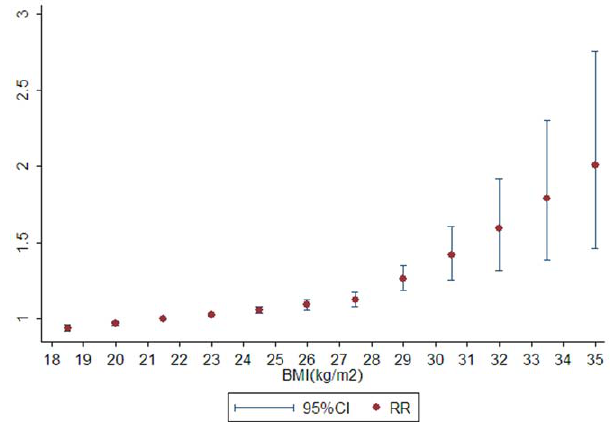
Figure 4. The curve of body mass index and relative risk of liver cancer in White population.